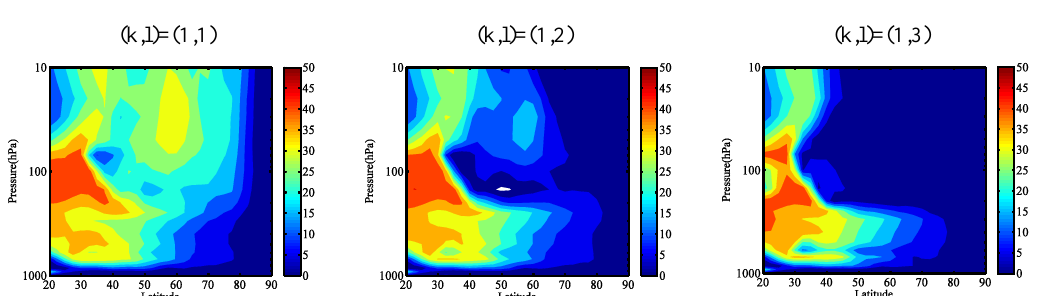
Figure 10. The differences between the probability of positive vertical wave number squared and the probability of favorable propagation condition of stationary Rossby